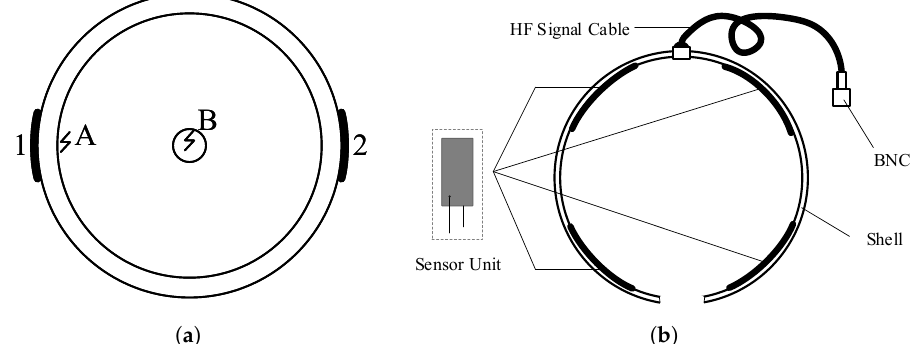
Figure 7. Schematic diagram of the PD source location and TEV sensor array structure. ( a ) Schematic diagram of PD sources at different locations. ( b ) Structure of the sensor array with four sensor elements.